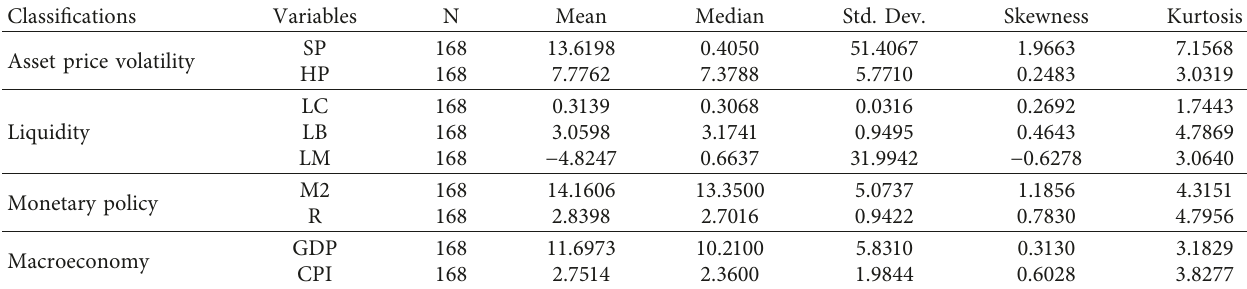
Table 1: Descriptive statistics of the main